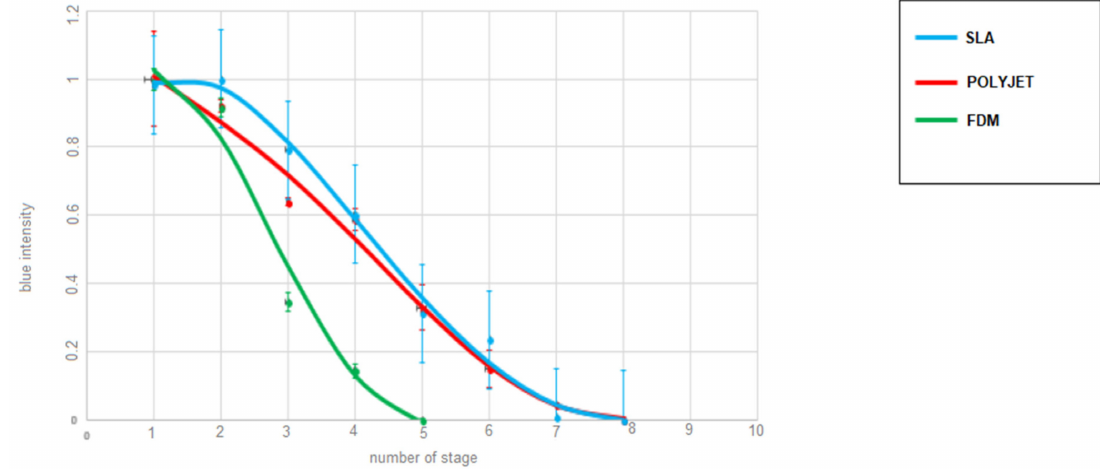
Figure 11. Required channel length for complete mixing (at a flow rate of 10 µ L / min) for the di ff erent 3D printing